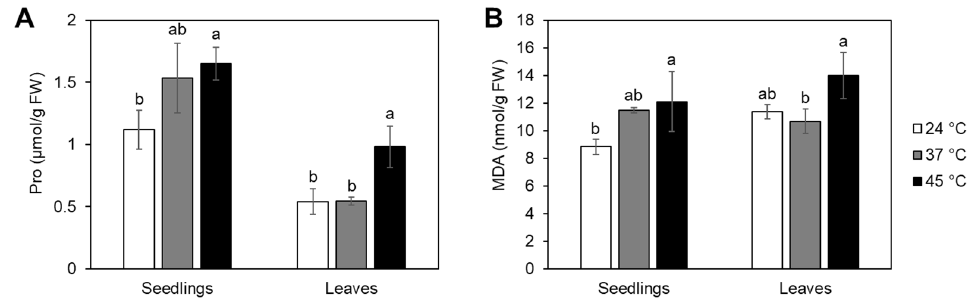
Figure 5. Proline (Pro) and malondialdehyde (MDA) content in tomato seedlings and adult plant leaves under heat stress. Seedlings or adult plants were either treated continuously at 37 °C or at 45 °C followed by recovery. Control plants were kept at 24 °C (Figure S1C,D). Pro ( A ) and MDA ( B ) contents were measured from whole seedlings or leaves harvested 24 h from the start of the treatments and expressed per fresh weight (FW). Each biological replicate consisted of 15 seedlings or leaves pooled from 6 adult plants. Data represent the average of 3 replicates with standard deviations denoted by vertical bars. Different letters indicate a significant difference between control and heat treatments at p < 0.05 (Tukey’s test) for each tissue type separately.